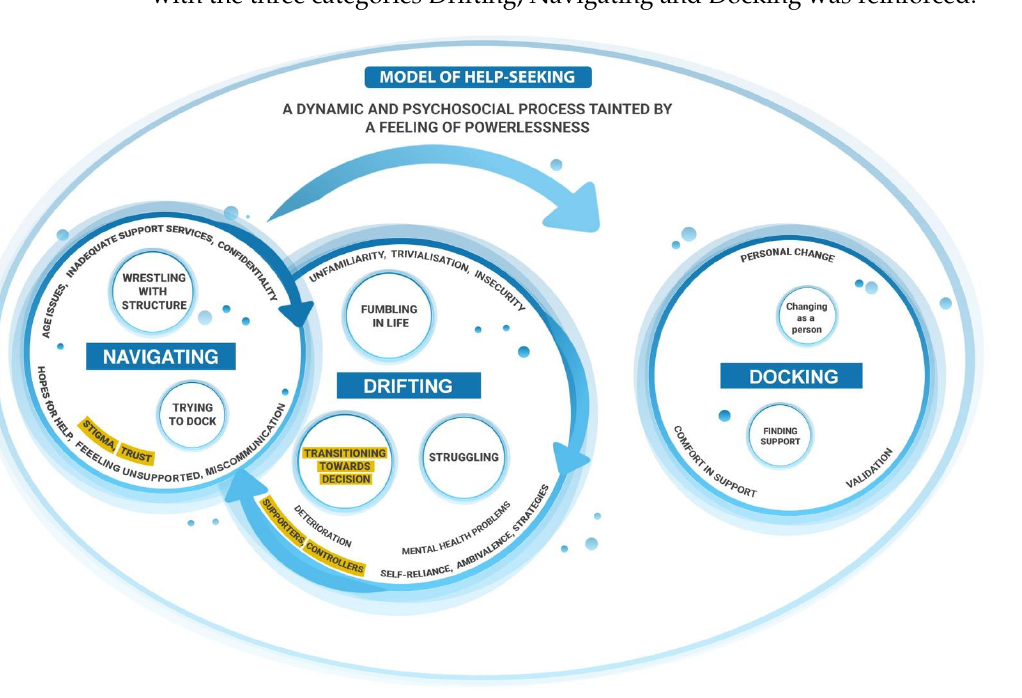
Figure 3. Elaborated and further developed theoretical model of help-seeking among young people for mental health for mental health problems.